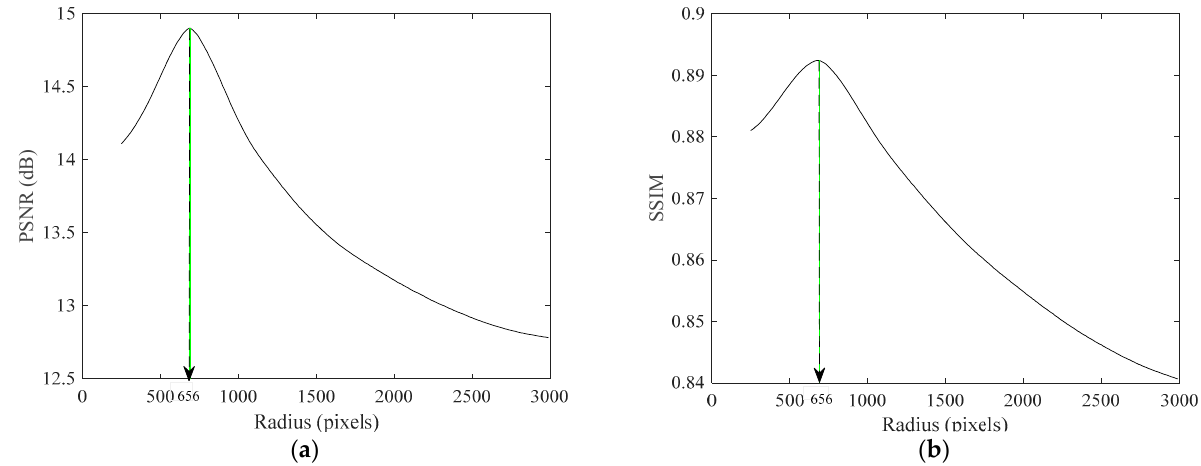
Figure 7. Stability assessment of different spherical radii: ( a ) peak signal-to-noise ratio (PSNR) stability assessment; ( b ) structural similarity index (SSIM) stability assessment.